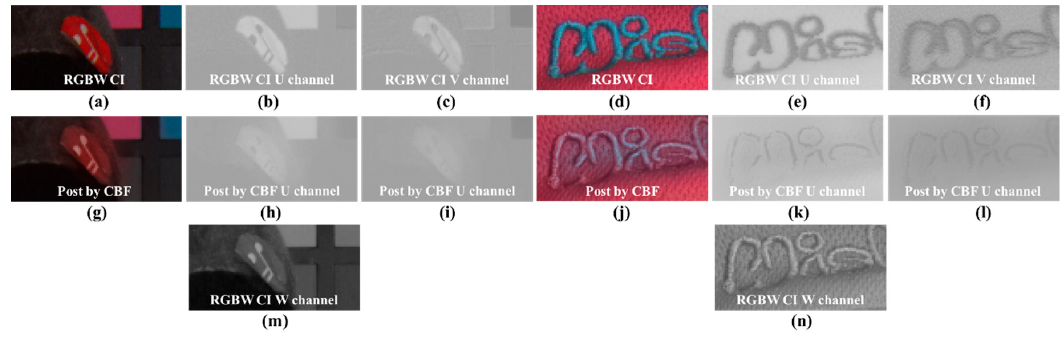
Figure 7. Examples of the kernel estimation error: ( a , d ) RGB channels of Sony RGBW CFA demosaicing result [24]; ( b , e ) U channel of ( a , d ); ( c , f ) V channel of ( a , d ); ( g , j) RGB channels of post-processing result by CBF; ( h , k ) U channel of ( g , j ); ( i , l ) V channel of ( g , j ); ( m , n ) W channel of Sony RGBW CFA demosaicing result [24].